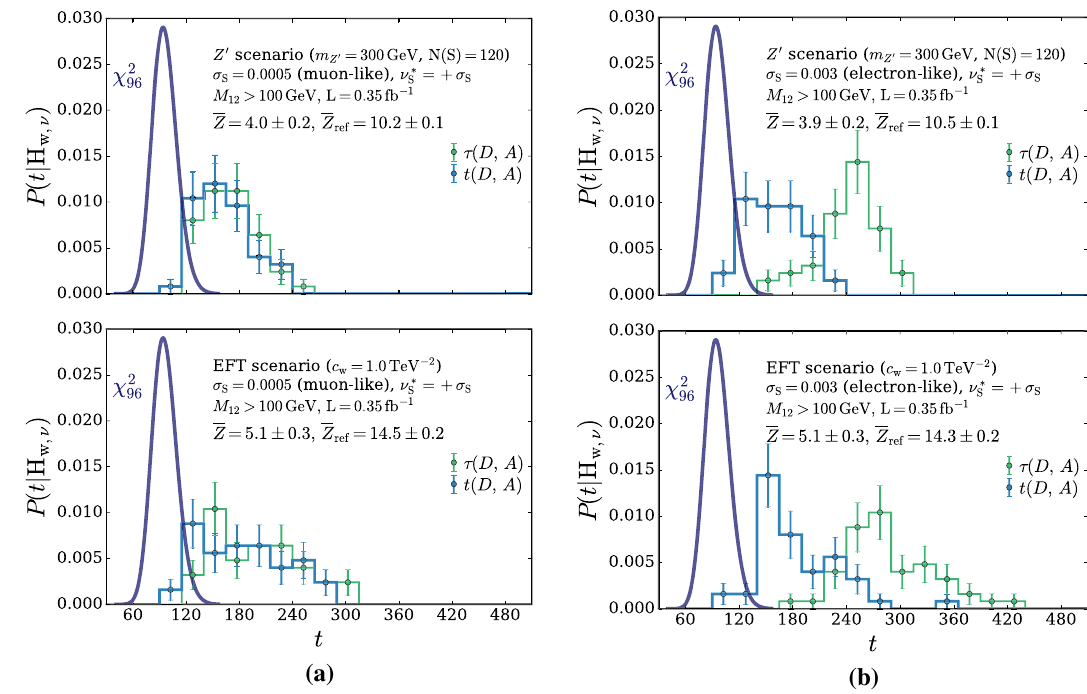
Fig. 23 Sensitivity to two New Physics scenarios in the muon-like ( a ) and electron-like ( b ) regimes. The upper panels show the sensitivity of the method to the presence of a Z (cid:16) ( m Z (cid:16) = 300 GeV, N ( S ) = 120) resonance in the two leptons invariant mass. The lower panels show the